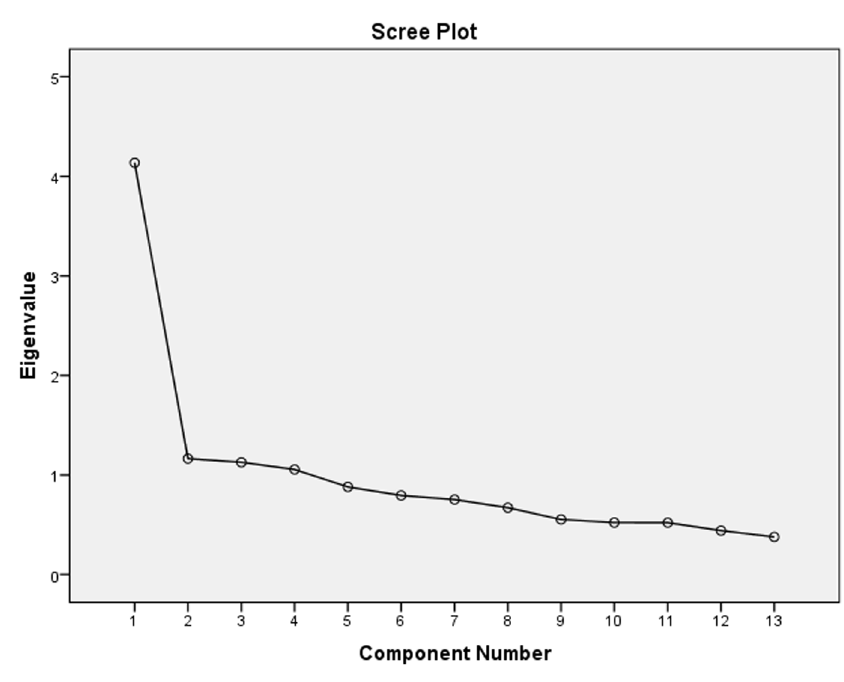
Figure 1. Factor components for the Chinese Toronto Mindfulness Scale – Trait Version (n =